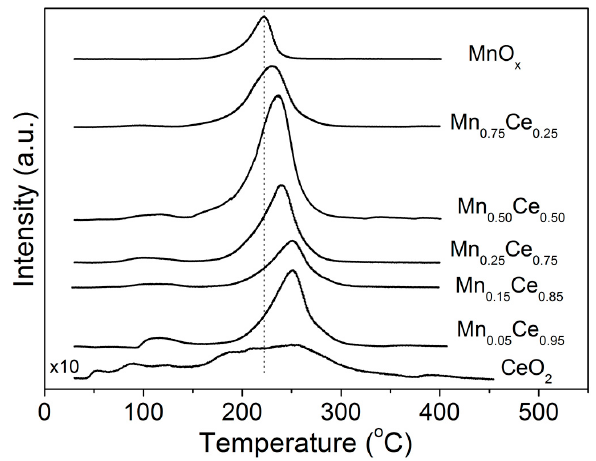
Figure 5. CO 2 profiles during TPO of ethanol over Mn x Ce 1 − x catalysts.